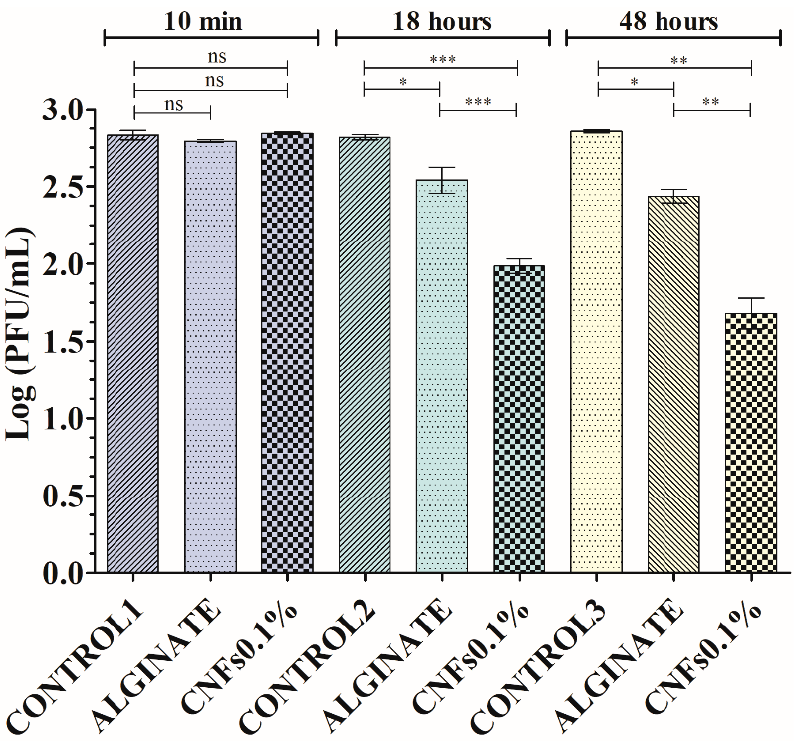
Figure 2. Antiviral activity results of control, alginate films, alginate/carbon nanofibers composite films (CNFs0.1%) after 10 min, and 18 and 48 h of contact with the bacteriophage T4 viral model. *** p > 0.001; ** p > 0.01; * p > 0.05; ns: not significant.